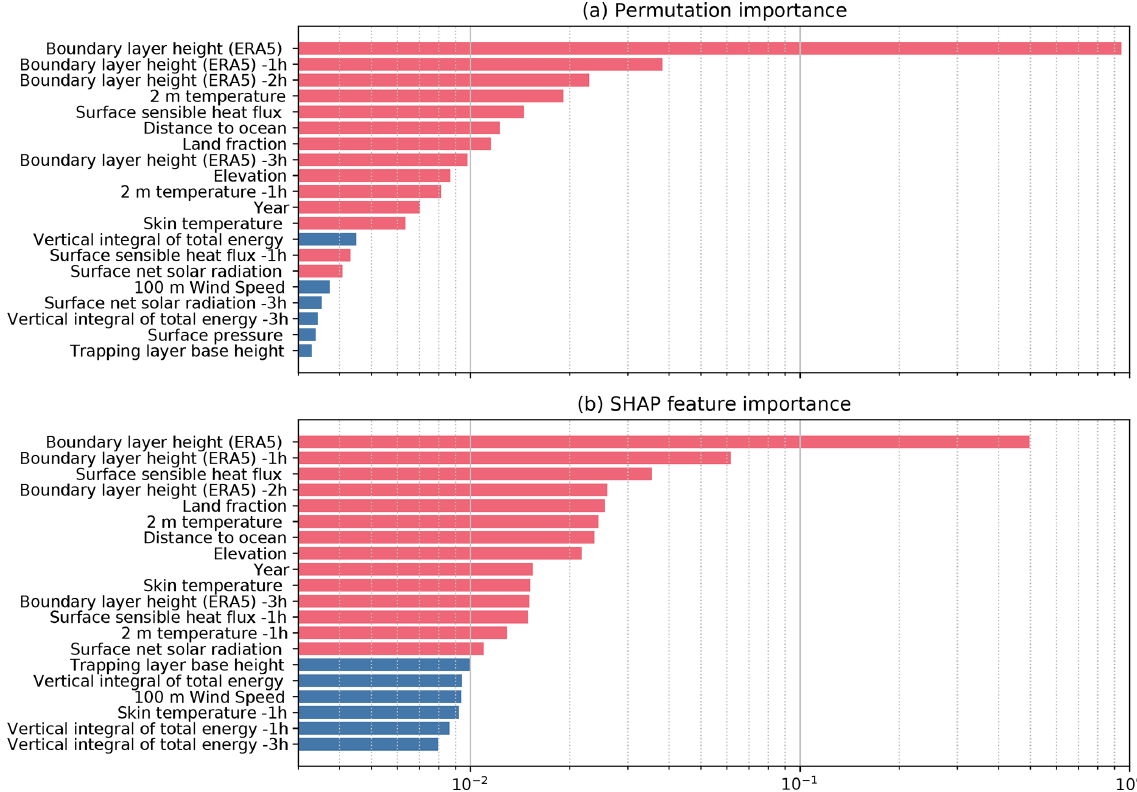
Figure 5. The feature importance values calculated by permutation importance (a) and the SHapely Additive exPlanations (SHAP) approach (b) . All initial predictors were included in the calculation, and only the top 20 predictors are shown. Red bars denote the predictors that are included in the final